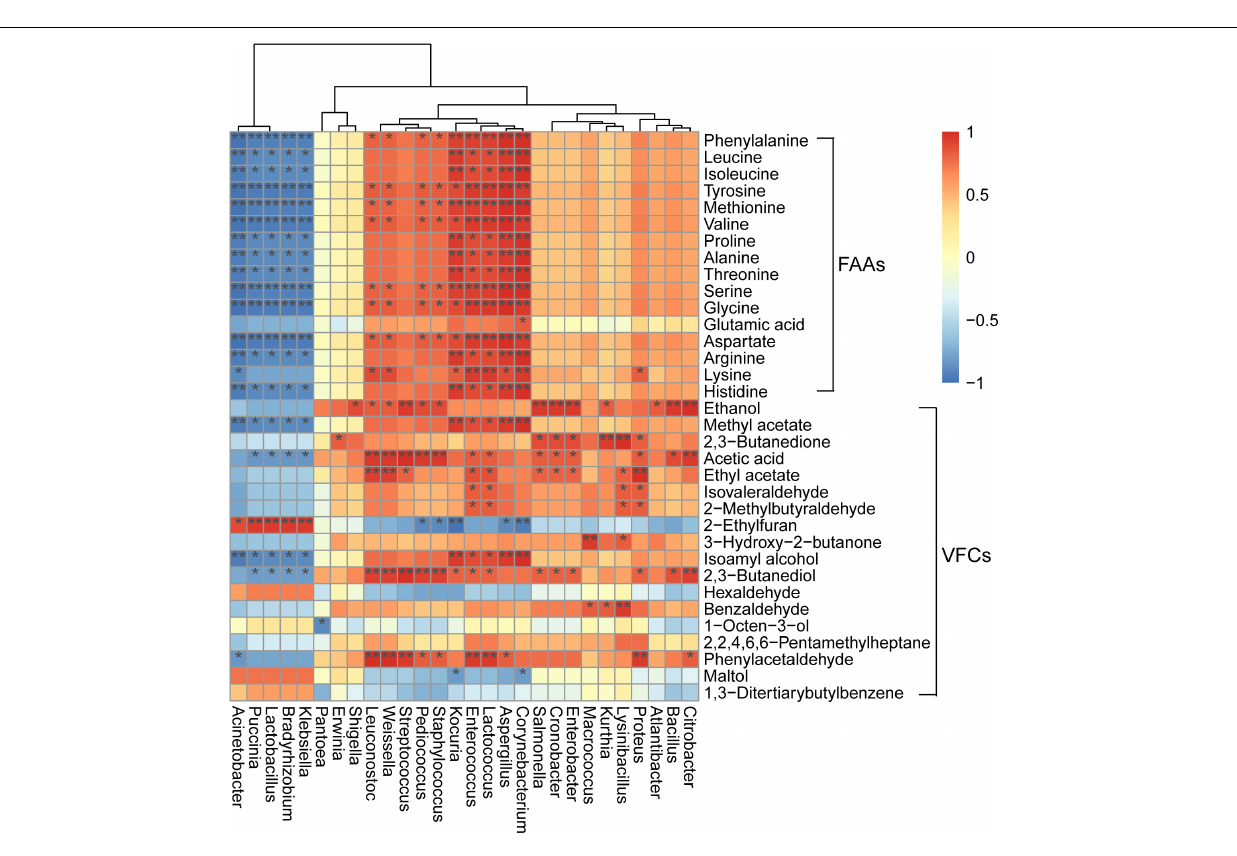
FIGURE 4 | Heatmap of correlations among microbial genera and metabolites. Correlation strength (based on Spearman’s r -value) and correlation significance values are shown as shaded colors (red, positive correlation; blue, negative correlation). Heatmap values range from + 1.0 to − 1.0. Values above/below zero represent positive/negative correlations, respectively, between genera and parameters. * p < 0.05, ** p <